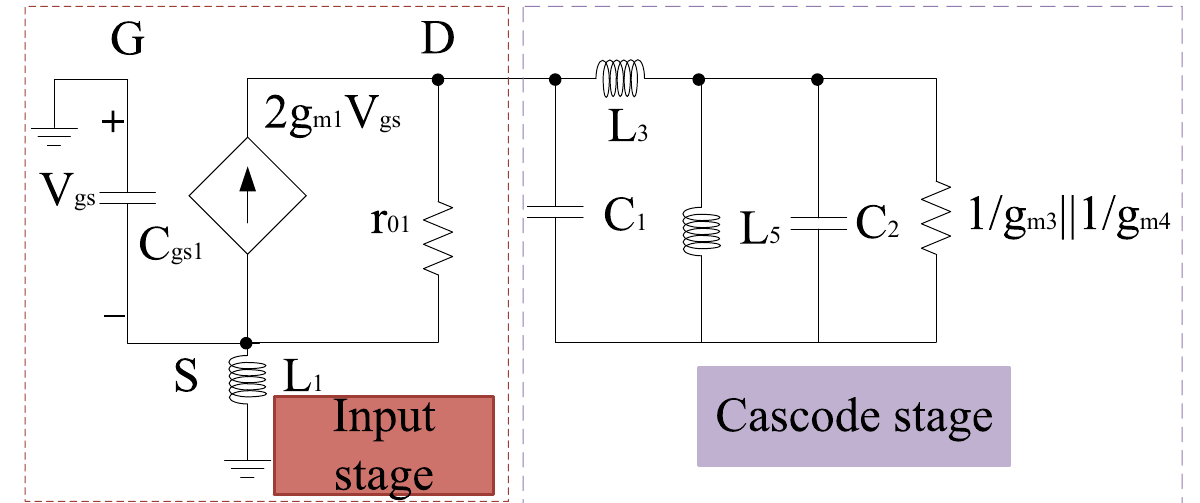
Figure 2. Small signal model.